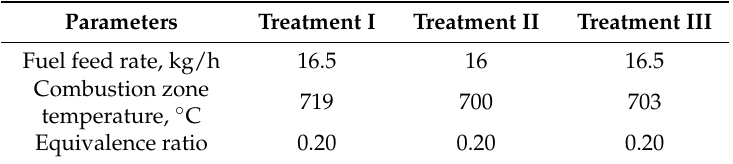
Figure 2. Wood shavings filter column installed with a gasifier system at Oklahoma State University.